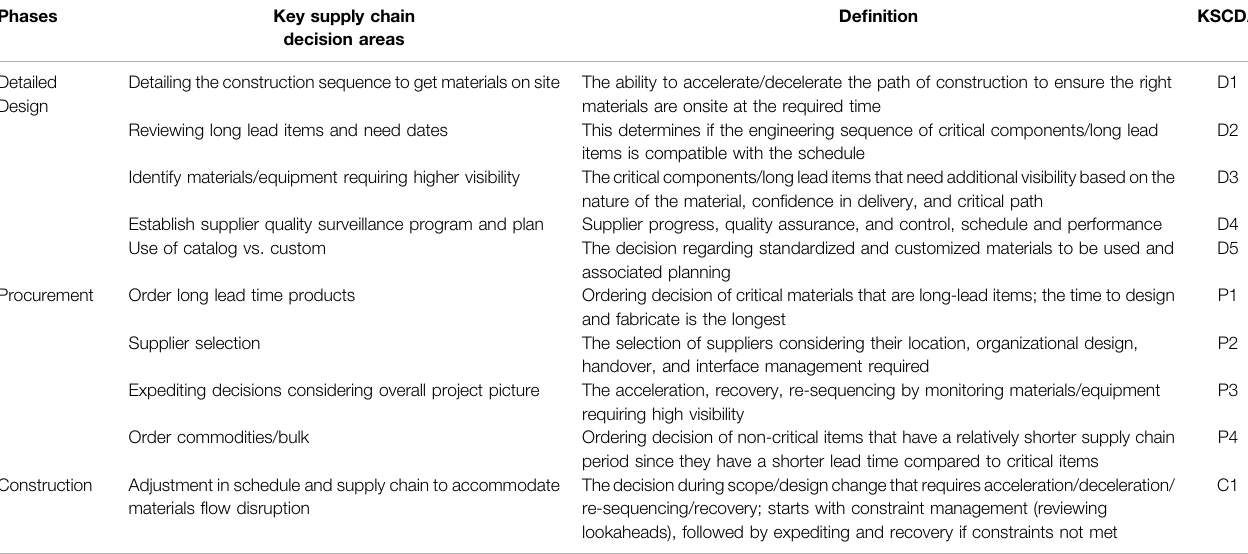
TABLE 3 | Project phases and key supply chain decision areas within each